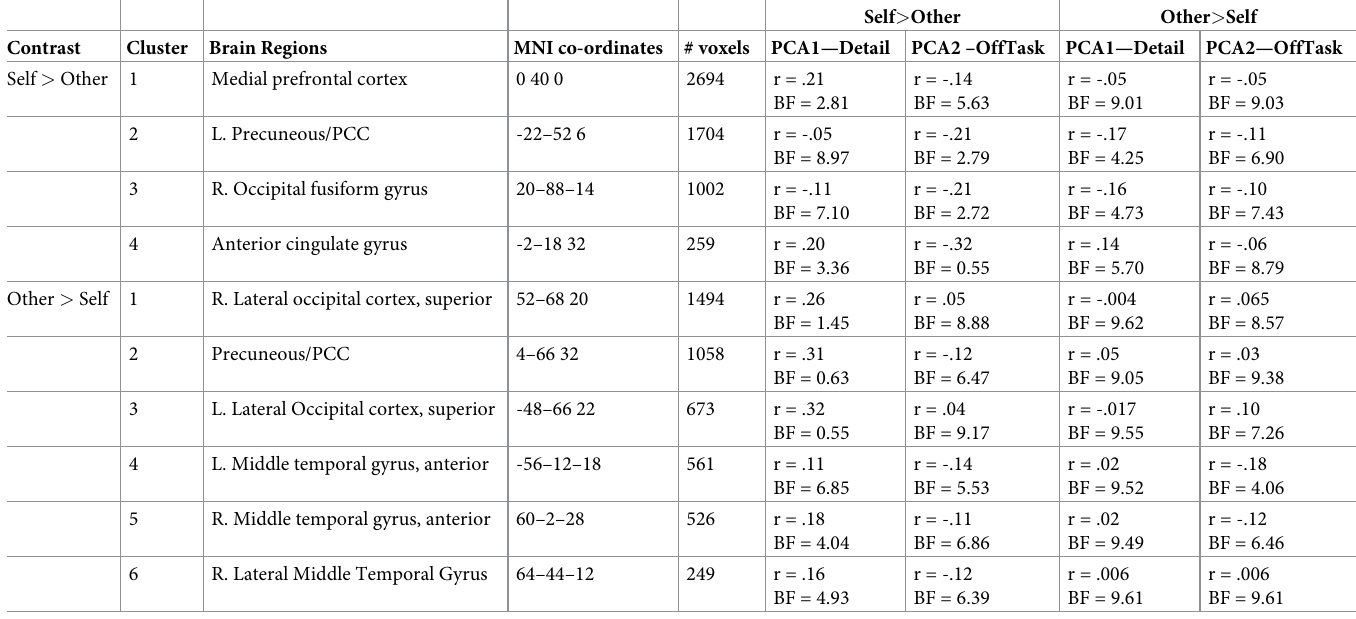
Table 2. Bayesian analysis